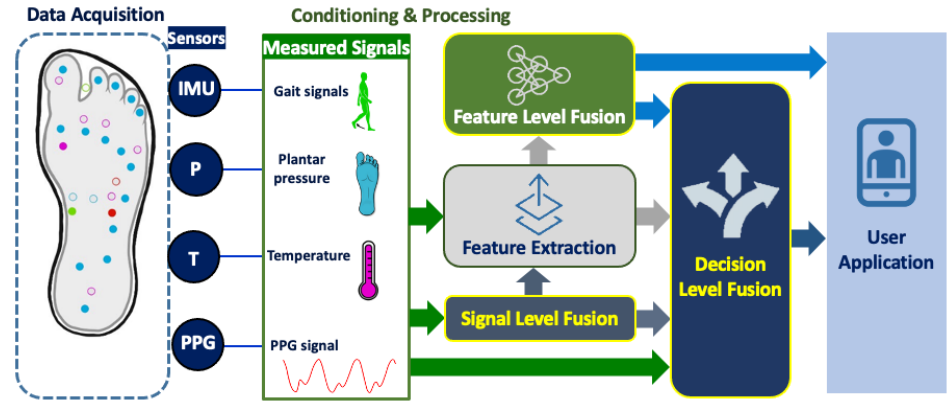
Figure 7. Sensor fusion in a multimodal insole-based system.